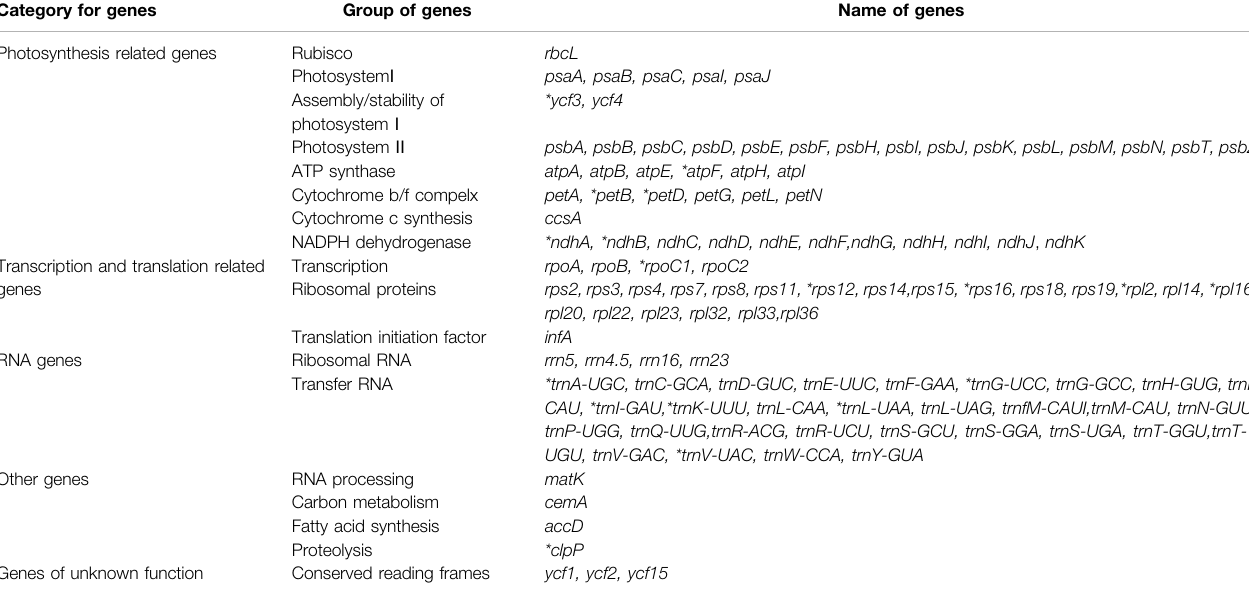
TABLE 1 | The basic chloroplast genome information of L. cardiaca species. Category for genes Group of genes Name of genes Photosynthesis related genes